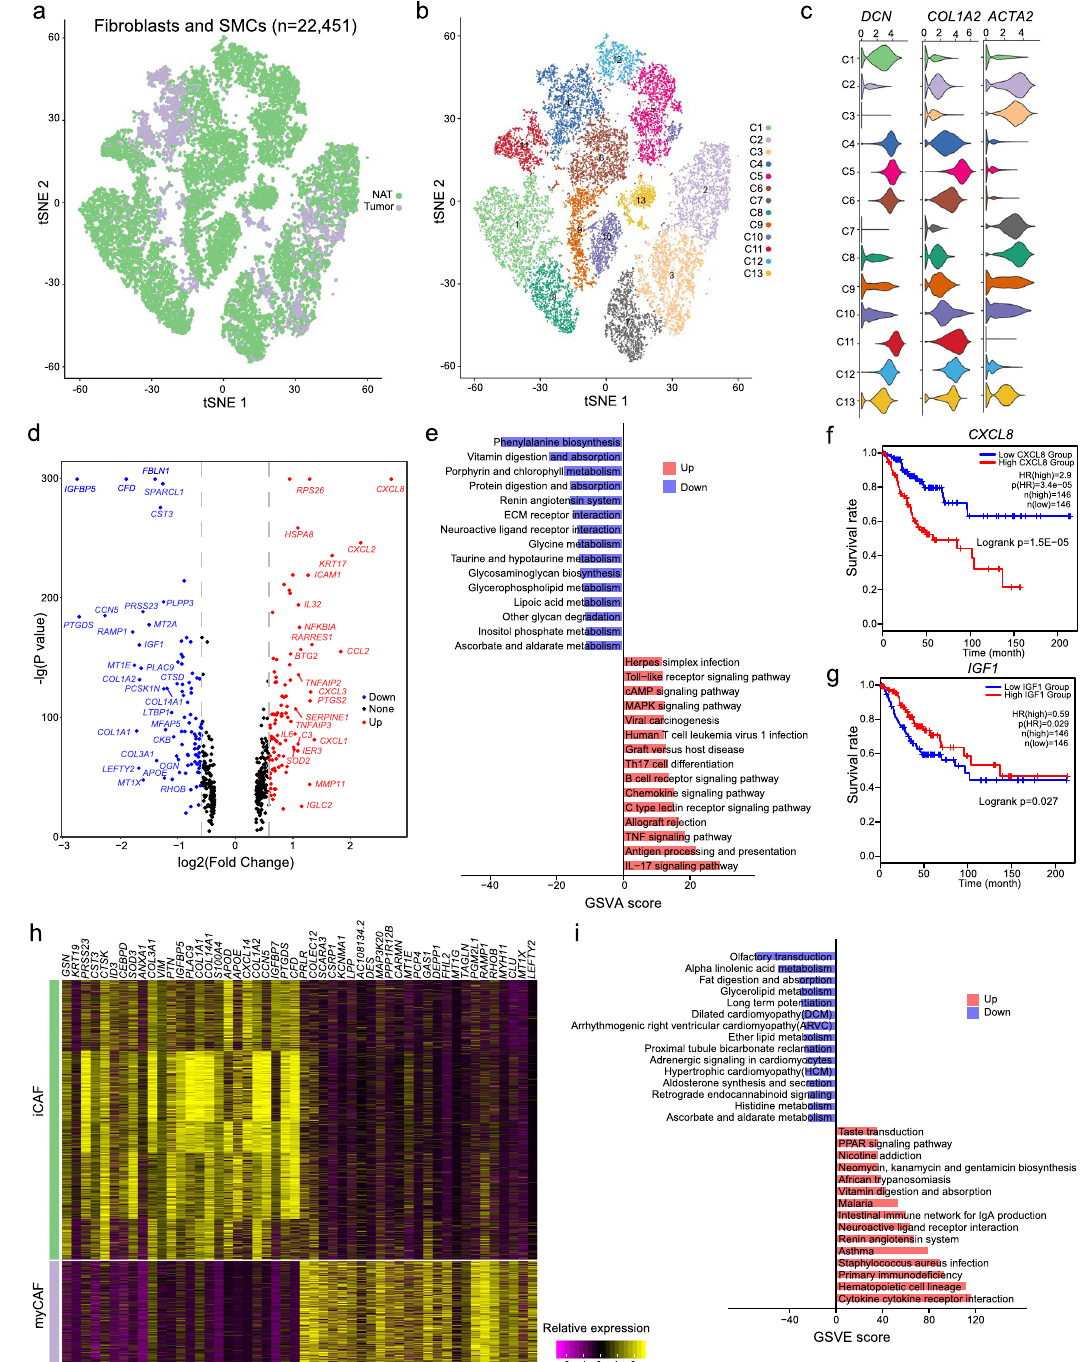
Fig. 3 Cellular and molecular heterogeneity of fi broblasts in CC. a tSNE plot showing fi broblasts and SMCs in tumor and NAT cervical samples. b tSNE plot showing fi broblast subclusters. c Relative expression levels of the DCN , COL1A2 , and ACTA2 gene across 13 fi broblast/SMC subclusters. d Volcano plot showing gene expression differences between tumor and NAT fi broblasts. e Bar plots showing the relative activities of upregulated and downregulated biological processes in tumor fi broblasts. f The Kaplan – Meier survival curve of CXCL8 in the TCGA cervical cancer cohort. g The Kaplan – Meier survival curve of IGF1 in the TCGA cervical cancer cohort. h Heatmap shows differential genes between iCAF and myCAF cells. i Bar plots showing the relative activities of upregulated and downregulated biological